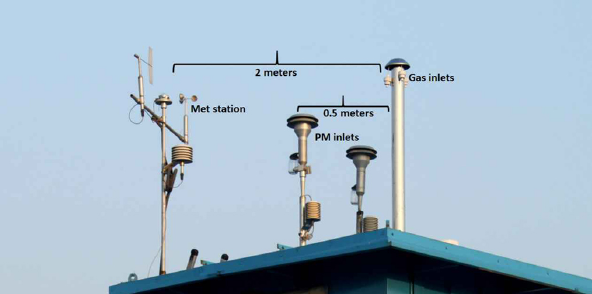
Figure 5. Picture of the co-located instrument inlets and meteo- rological sensors ( ∼ 20ma . g . l . ) at the IISER Mohali atmospheric chemistry